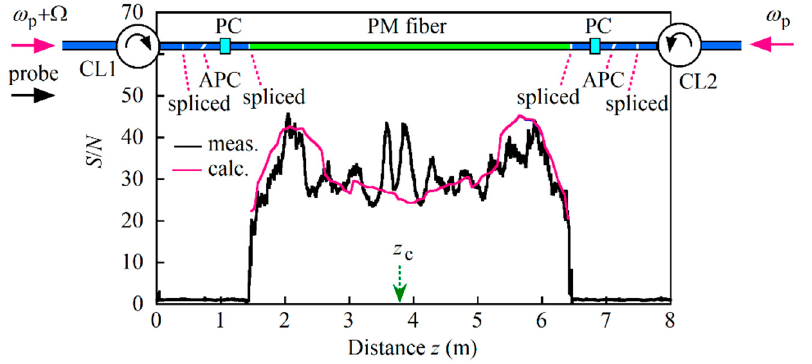
Figure 10. Comparison of the measured and calculated S/N along a 5 m long polarization- maintaining (PM) fiber, where the up-conversion frequency was 10.881 GHz and the DFB LD was driven with current source B whose power spectral density is shown in Figure 5b. Both ends of the PM fiber were spliced to 250 μ m buffered single-mode fibers with APC connectors which were mated to those of the fiber pigtails of optical circulators CL1 and CL2. z c (=3.8m) is the distance to the center of pumping. The fast and slow axes of the PM fiber were excited by the respective probe light and counter-propagating pump lights by using in-line polarization controllers (PCs). CL1 and CL2 are optical circulators. ω p and ω p + Ω are the angular frequencies of the counter-propagating pump light waves. APC: Angled physical contact.